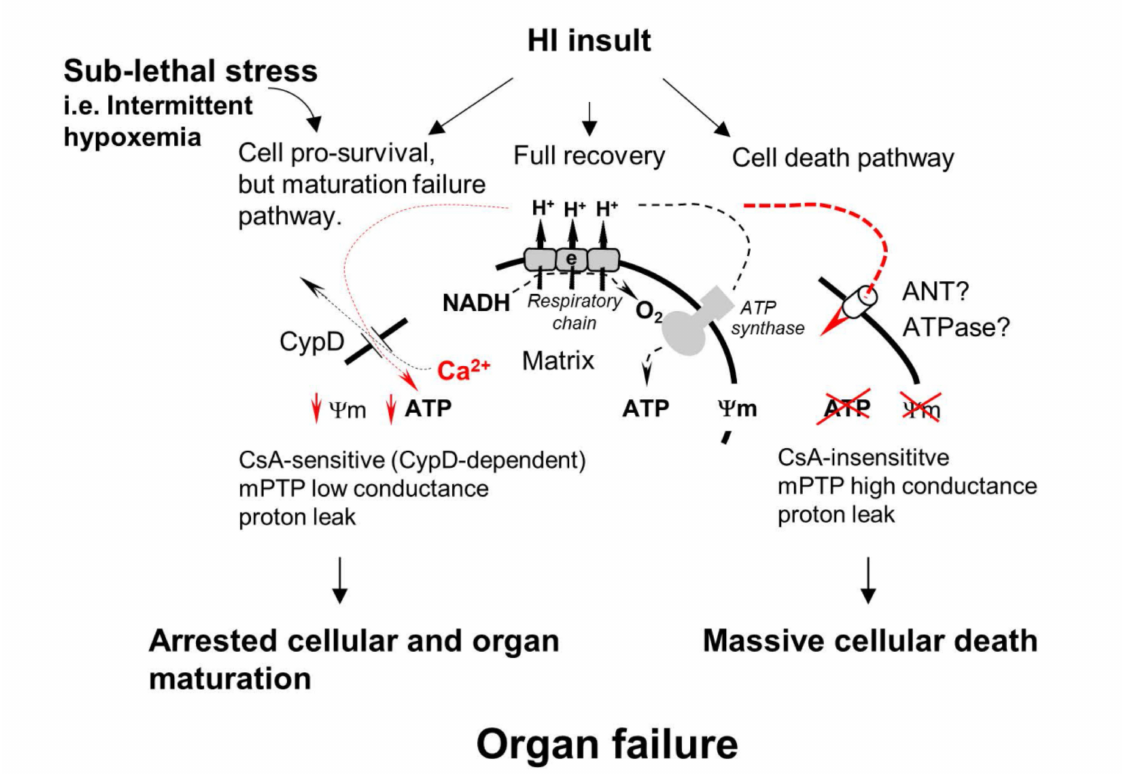
Figure 1. Schematic presentation of hypothetical roles of mPTP in various cellular fates after HI insult in the developing brain: full recovery and survival, death or survival but at the expense of maturation/differentiation failure. Based on current literature, we propose that in the developing brain, CypD-independent (ANT? ATPase? dependent) mPTP activation initiates secondary energy failure and cellular death, while CypD-dependent mitochondrial ion/proton leak promotes cellular viability following cell-lethal HI insult [47]. However, the same CypD-dependent mitochondrial proton/ion leak, via uncoupling of mitochondrial respiration in differentiating oligodendrocytes contributes to their maturation failure to reach myelin-producing stage leading to diffuse white matter hypomyelination [40]. Thus, it is possible that in the developing brain HI injury CypD-independent mPTP contributes to cellular degeneration and CypD-dependent proton leak supports cellular viability but contributes to the post-HI maturation failure of viable/survived